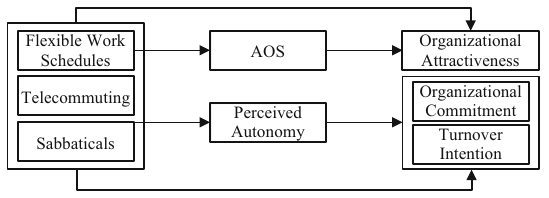
Fig. 1 Model linking FWPs to external and internal